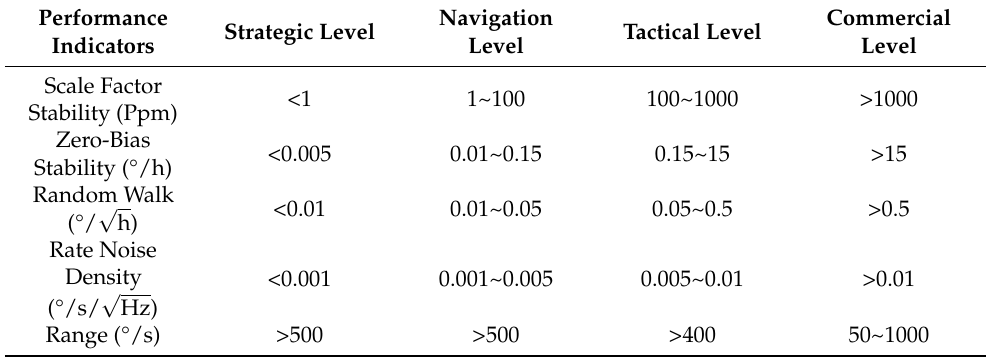
Figure 1. The cost of MEMS inertial sensors with varying degrees of accuracy in various application scenarios. Table 1. Approximate range of key parameters of gyroscopes for different classes of use.